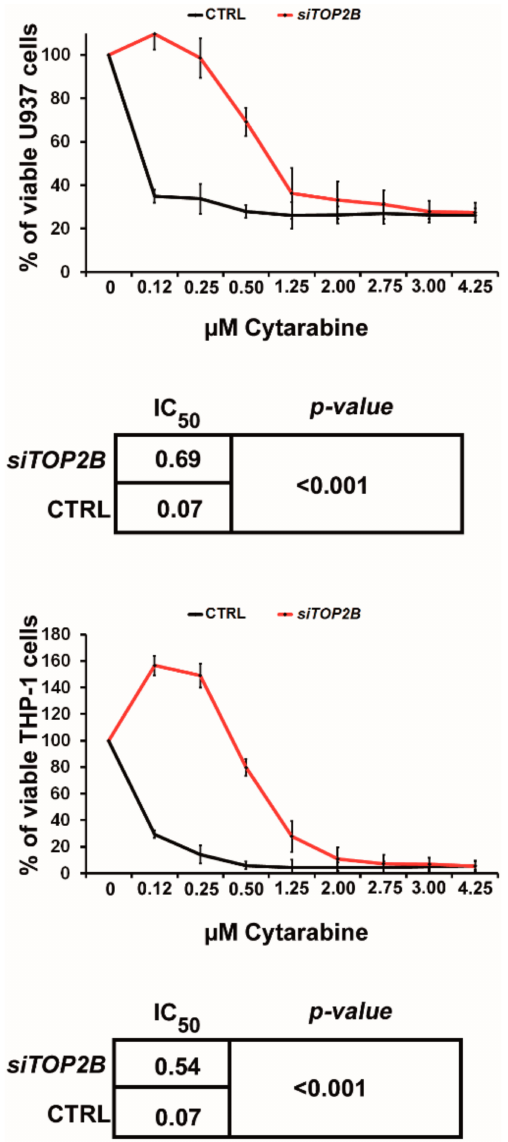
Figure 5. Sensitivity to cytarabine after TOP2B knockdown in AML cell lines. MTT cytotoxicity assays in AML cell lines after incubation with cytarabine. si TOP2B denotes transfection with a TOP2B siRNA; CTRL denotes transfection with a scrambled control siRNA. Experiments were repeated at least three times. The curves depict the mean ± SD. Statistical significance between IC 50 values was calculated using Student’s t